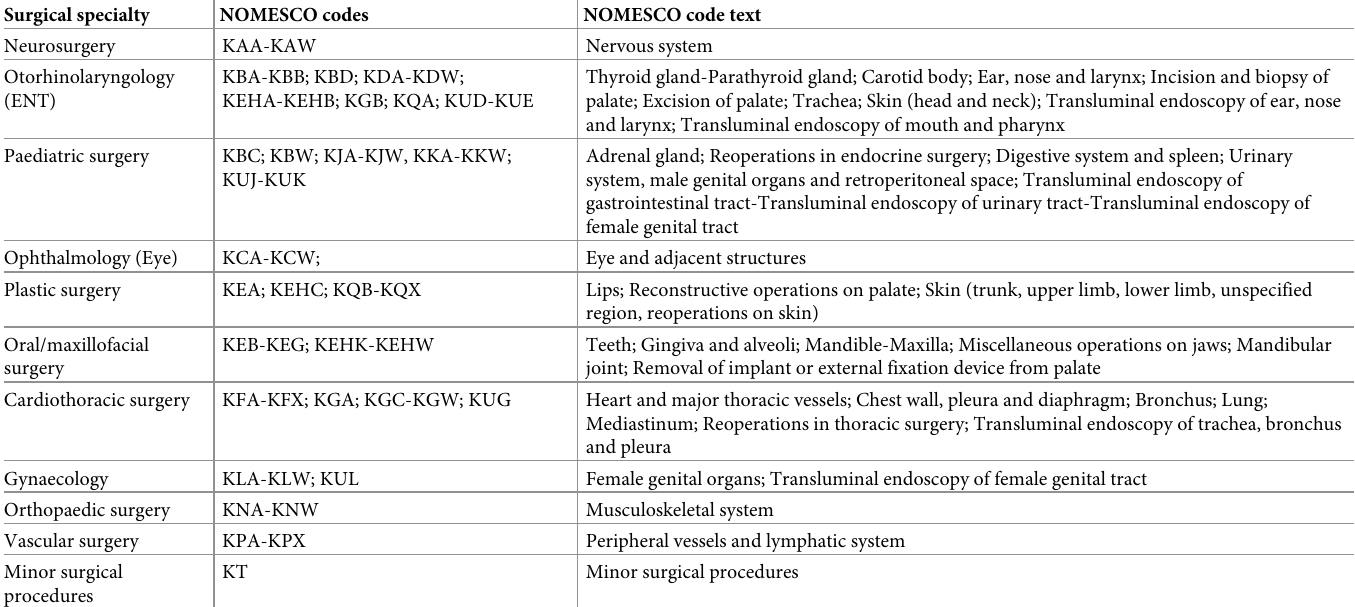
Table 1. Categorisation of procedure codes to define surgical specialties. Surgical